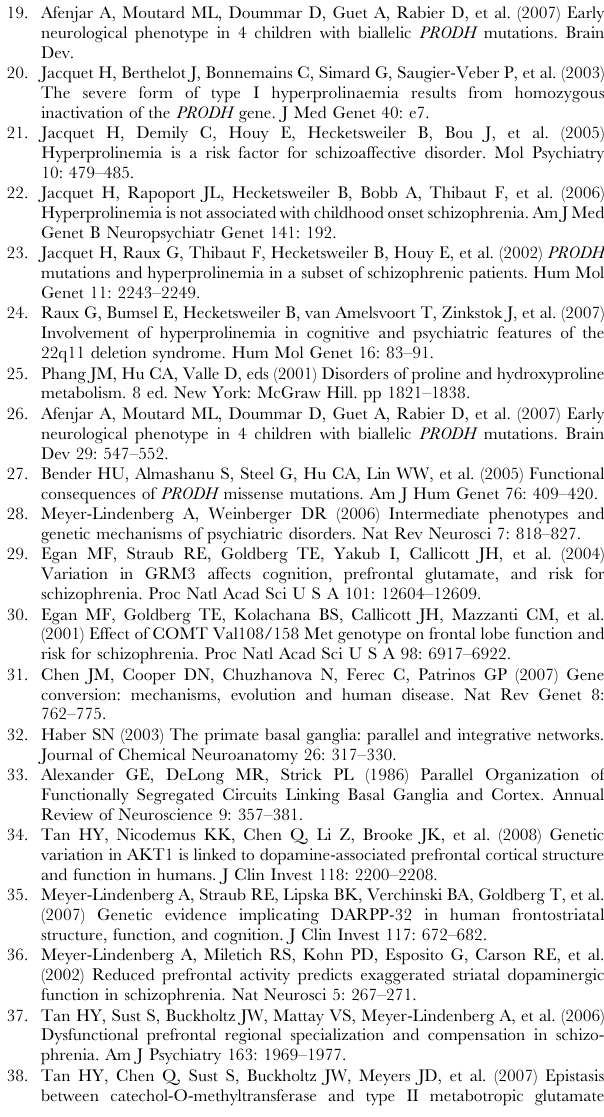
Table S3 Striatal functional connectivity.